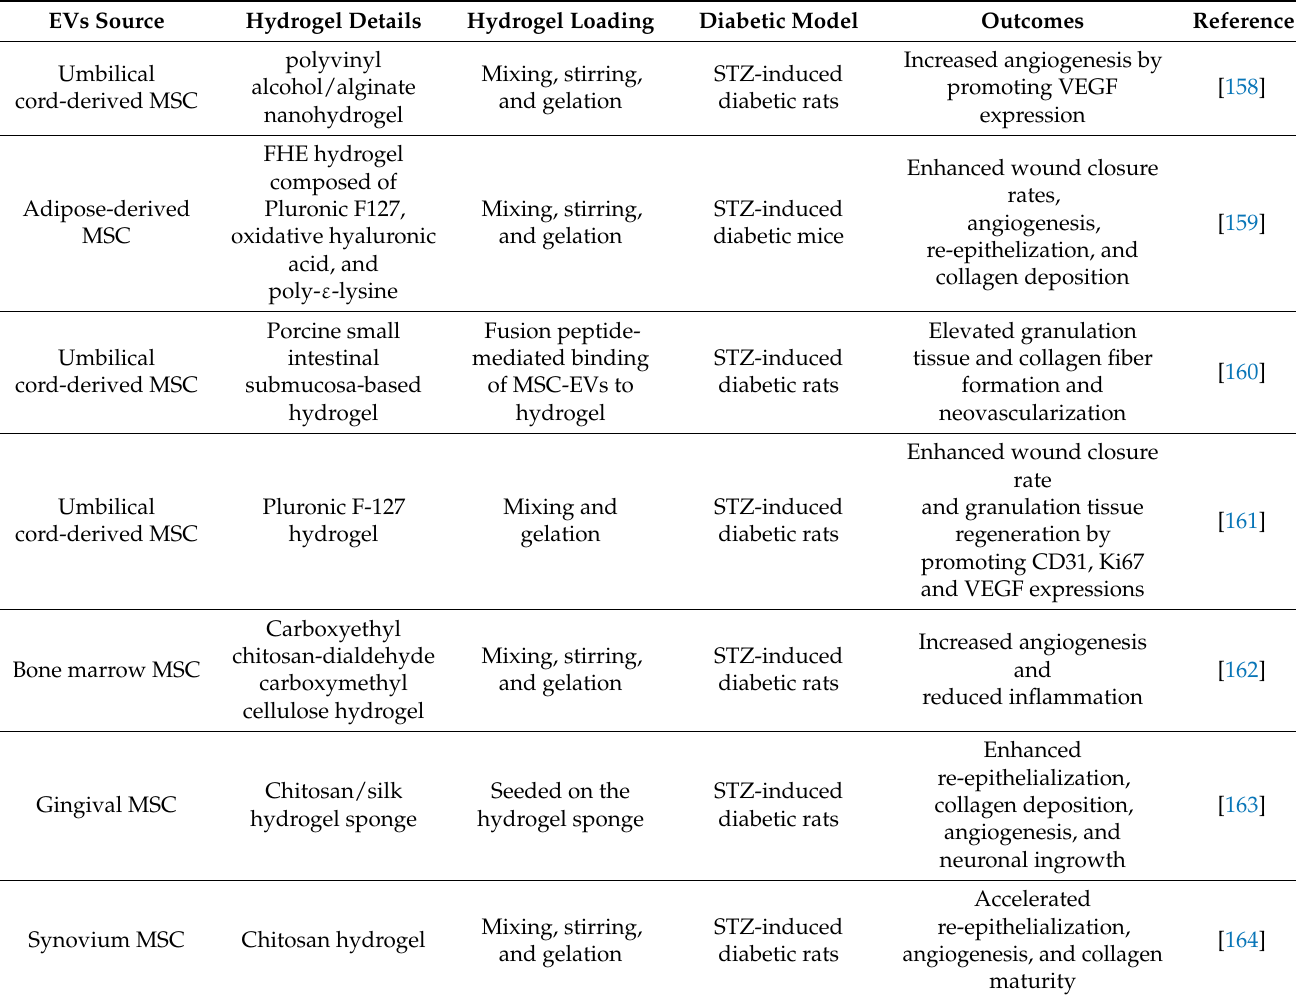
Table 3. Hydrogel-modified MSC-EVs for diabetic wound